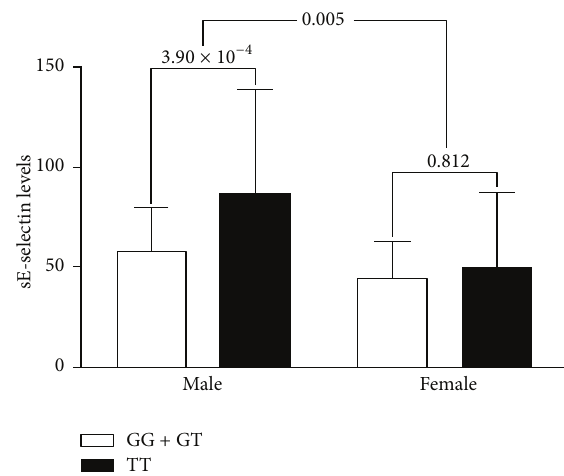
Figure 1: Comparison of levels of soluble E-selectin according to CDH13 rs12051272 genotypes in the recessive model between Han Chinese men and women in Taiwan. After adjustments for clinical covariates, minor alleles of CDH13 rs12051272 genotypes were found to be associated with higher sE-selectin levels, predominantly in men ( 𝑃 = 3.90 × 10 −4 ). Interaction analysis revealed an interaction of sex with the CDH13 rs12051272 genotypes (interaction 𝑃 = 0.005 ).